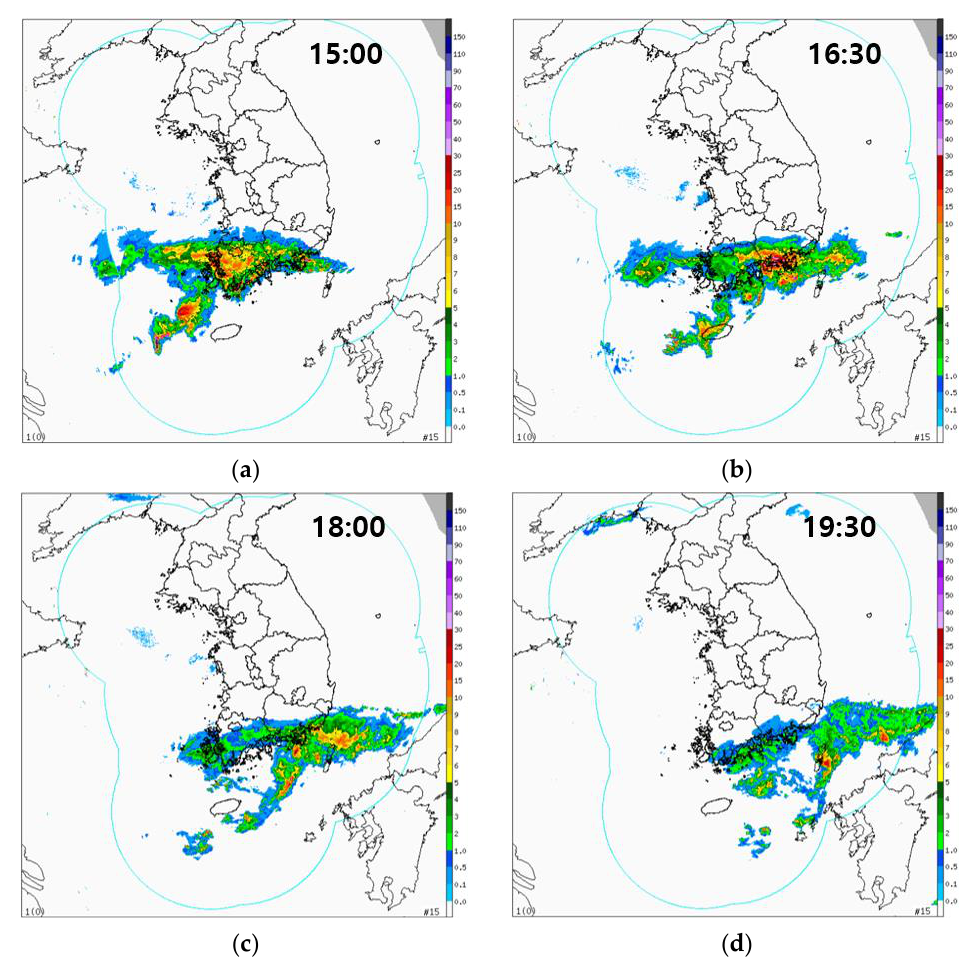
Figure 2. Rainfall intensity (mm/h) estimated from rainfall radar at ( a ) 15:00, ( b ) 16:30, ( c ) 18:00, and ( d ) 19:30 on 7 April 2019.